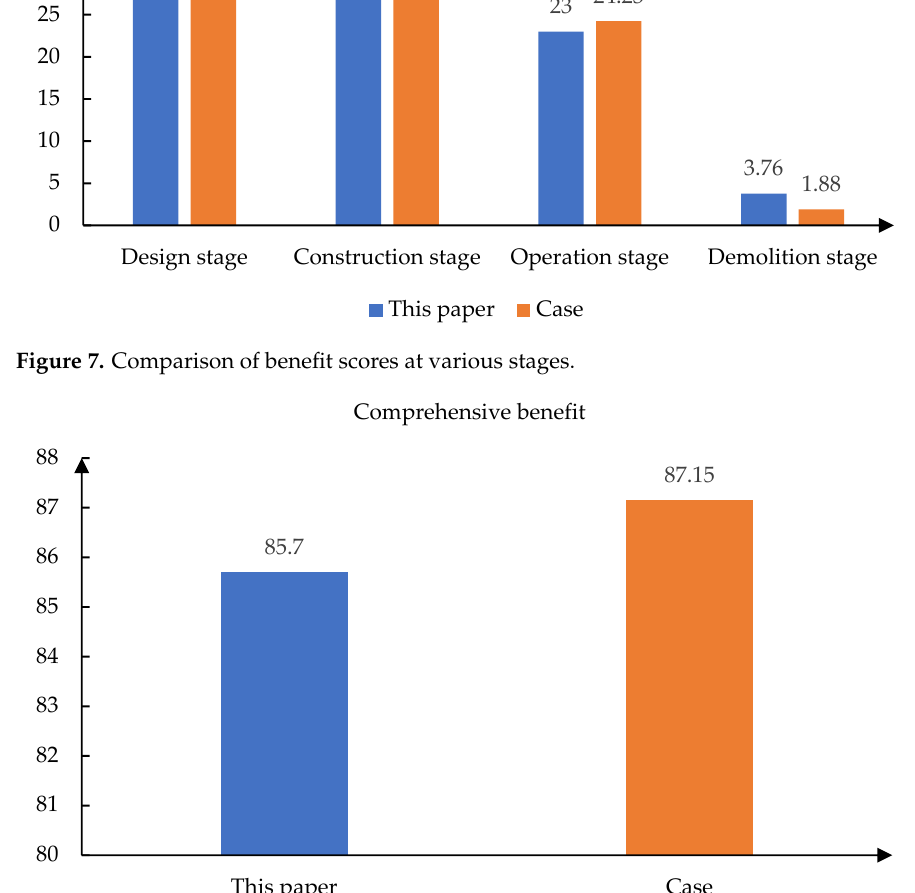
Figure 8. Comparison of comprehensive benefit scores.